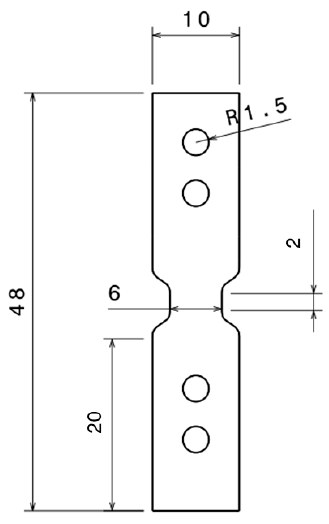
Figure 2. Specimen schematic for split Hopkinson tensile test (in mm). Table 1. Thickness of each specimen used in the simulation.